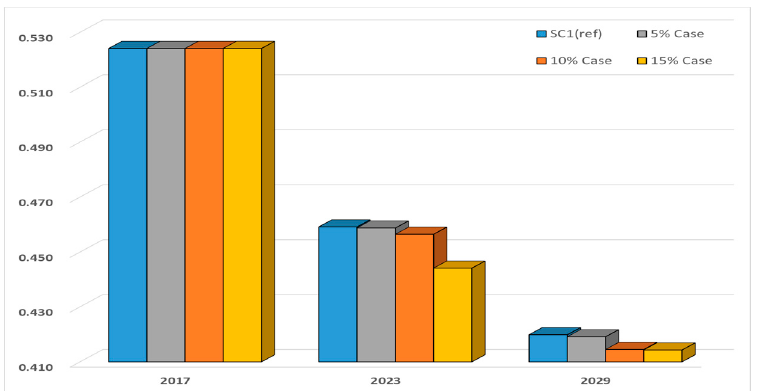
Figure 15. Changes in the emissions intensity (tCO 2 /MWh) of the power generation industry with CER price increases.